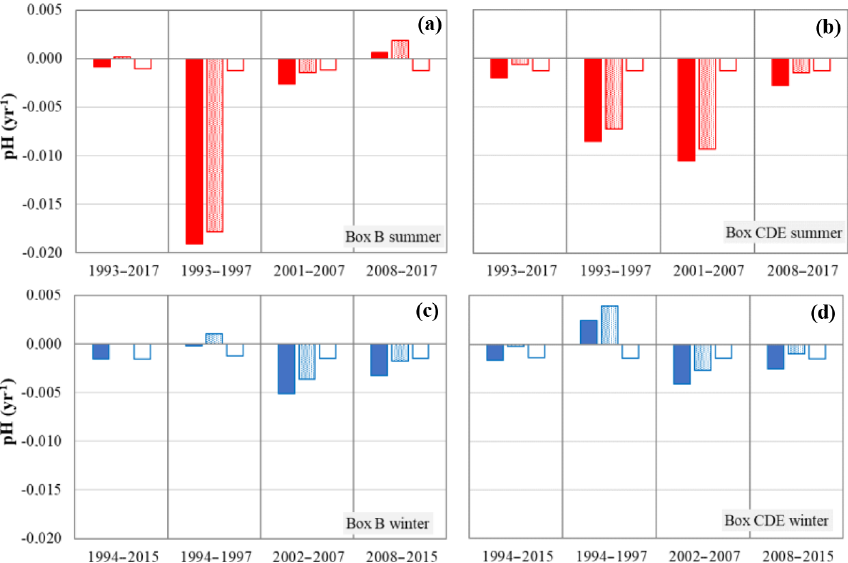
Figure 6. Decomposition of the trends in surface pH according to the effect of the changes in DIC-tot (filled), DIC-nat (dotted) and C-ant (open) during summer (a, b) and winter (c, d) for the long-term period and the three